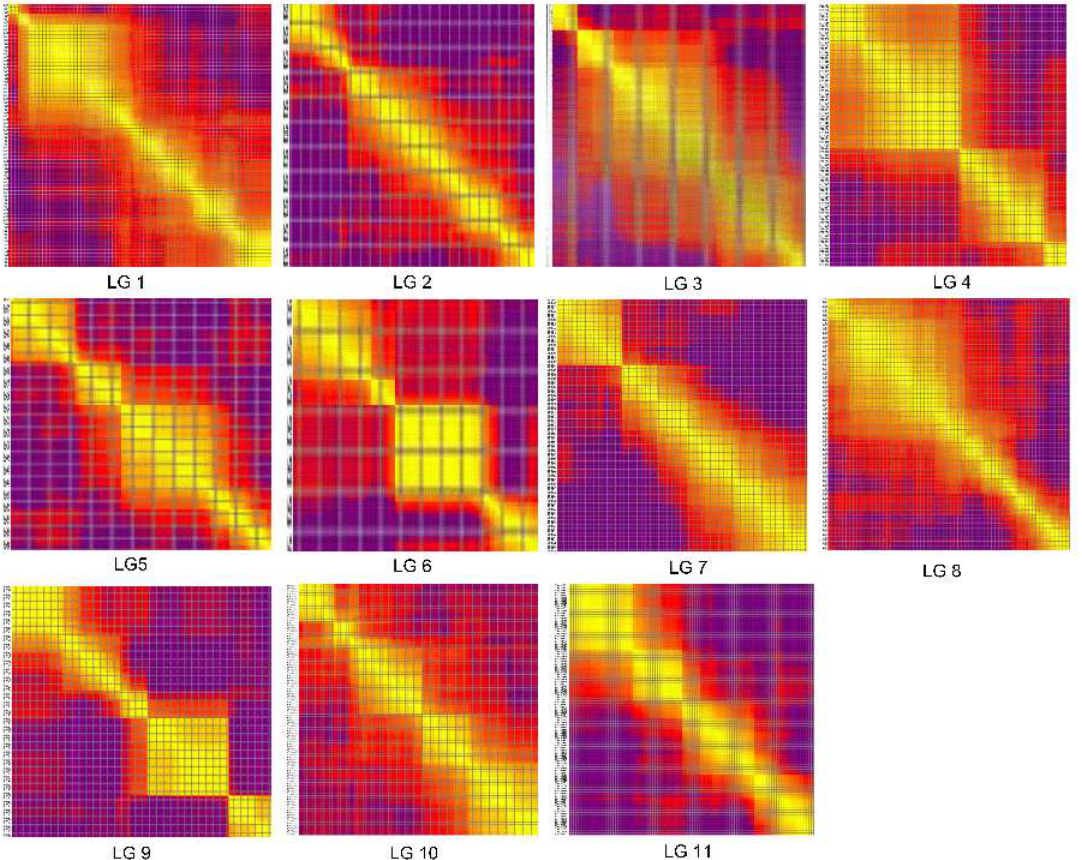
Figure 4. The heat map of genetic map. The x and y axis represent markers. The order of markers on line and row were arranged according to their genetic distance. Each cell represents the recombination rate of two markers. Yellow indicates a lower recombination rate and purple a higher one.